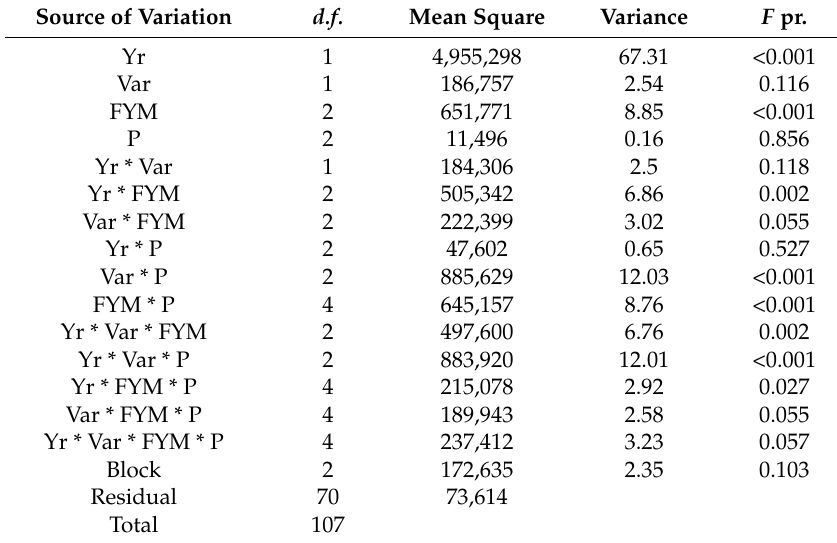
Table 6. Analysis of variance for yield performance of subsequent finger millet (in the 2013 and 2015 cropping seasons) as influenced by the residual effects of soybean precursors and the application of FYM and chemical P fertilizer at Bako, Western